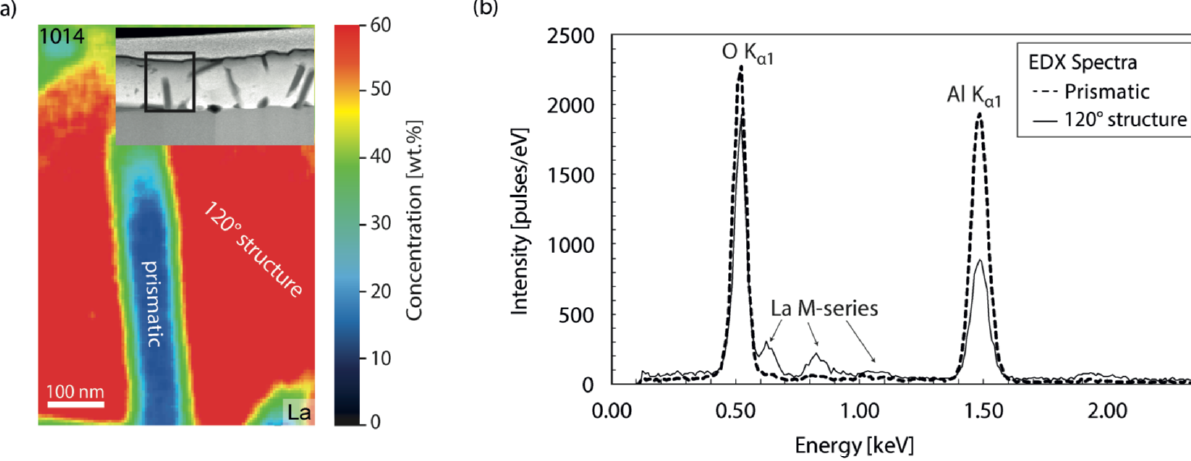
Figure 5. EDX analysis of the thin film in sample TH_9_5 (1014). (a) TEM EDX La element map of the crystallized thin film. (b) EDX spectra of two distinct areas in the thin film: the prismatic crystal and the foam texture part with 120 ◦ triple junctions,